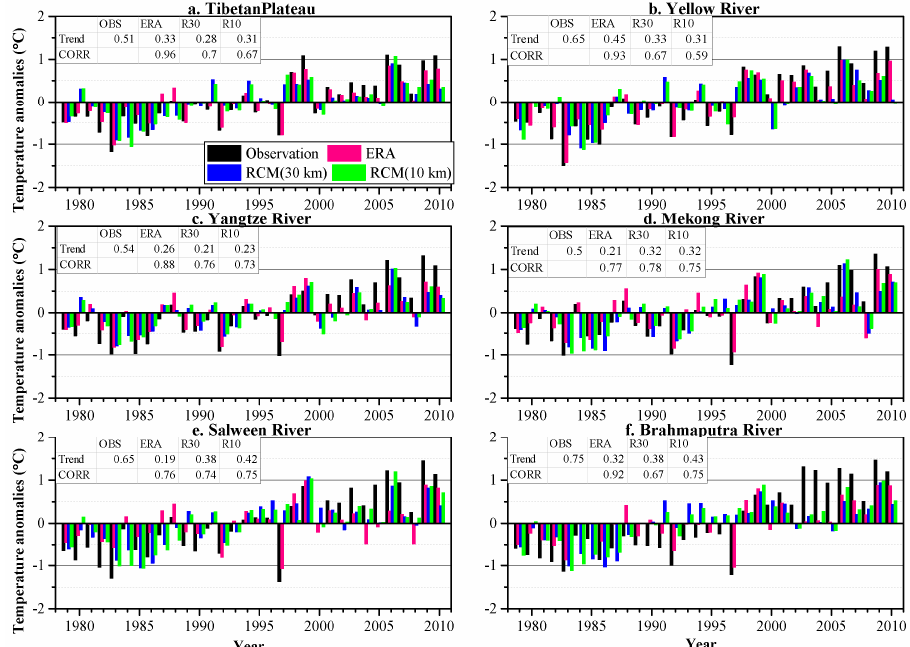
Figure 5. Annual mean temperature anomalies calculated from the observation, RegCM4 simulations, and the ERA-Interim reanalysis and the statistics (including the trend ( ◦ C / decade) and correlation coe ffi cient (CORR for short)) between them over the whole Tibetan Plateau (TP) ( a ) and five river basins ( b – f ) for the period 1980 − 2010.